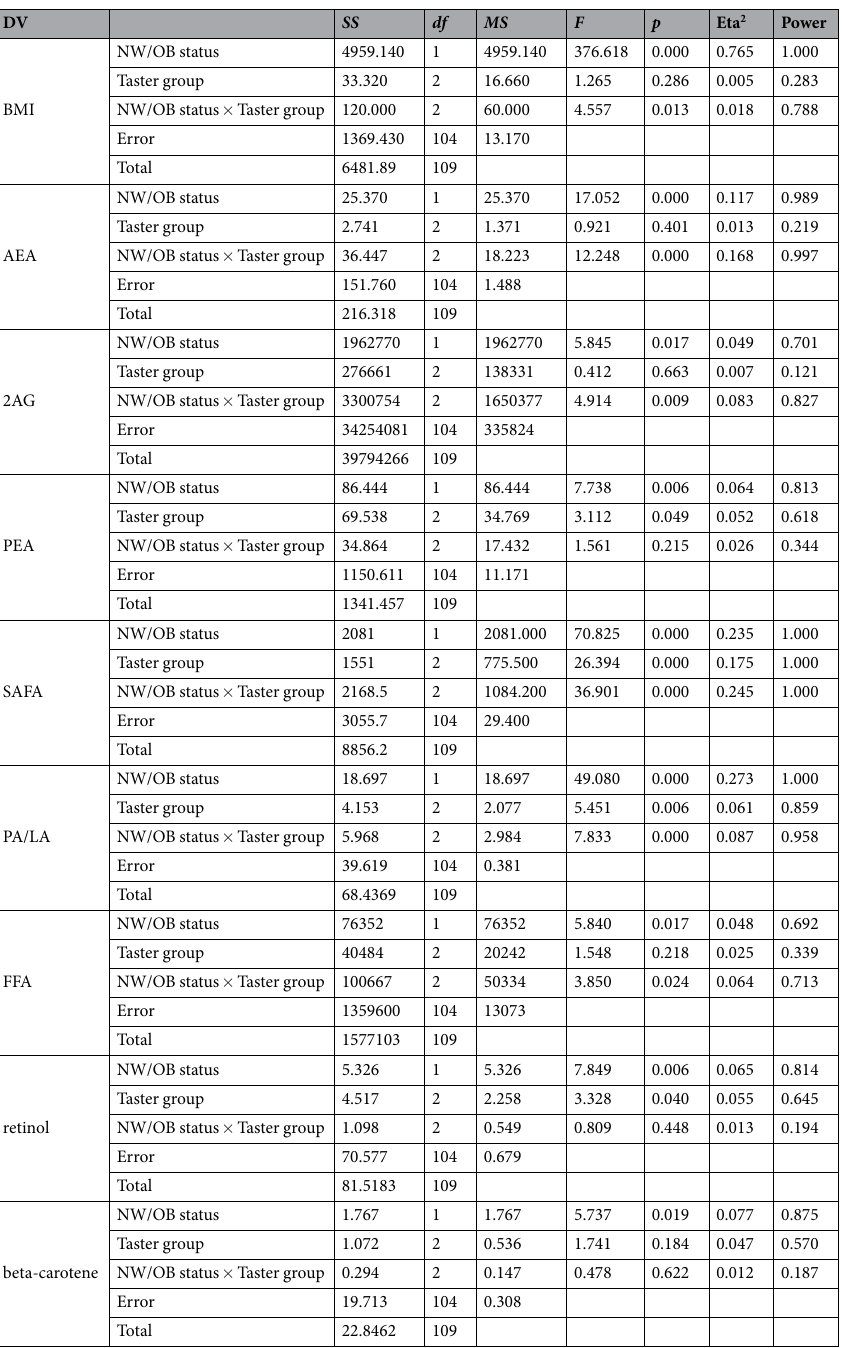
Table 4. Effect size and Power calculated for each dependent variable (DV) after conducting two-way ANOVA with PROP taste and NW /OB status as independent variables. SS, sum of squares; df, degree of freedom; MS, mean square; Eta 2 , parameter showing the effect